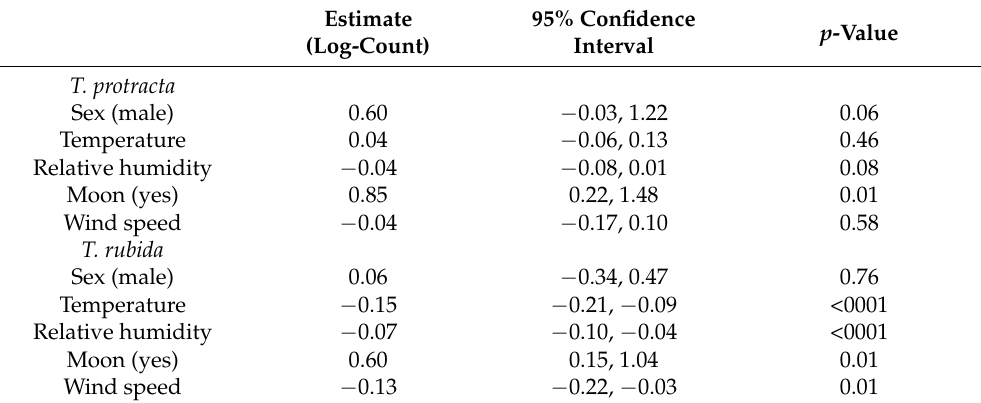
Table 1. Results of negative binomial regression for kissing bug flight count from 6 May 2020 to 17